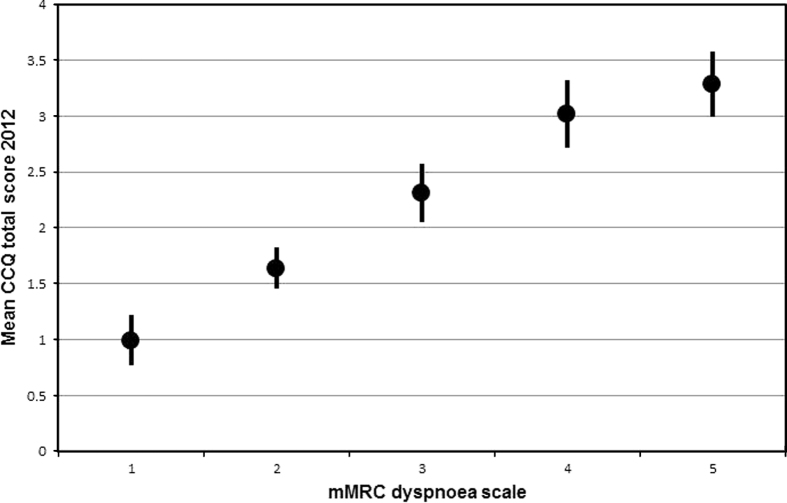
Dyspnoea and health status. Mean CCQ total scores in 2012 distributed over mMRC dyspnoea scale grades. CCQ, Clinical COPD Questionnaire; mMRC, modified Medical Research Council.